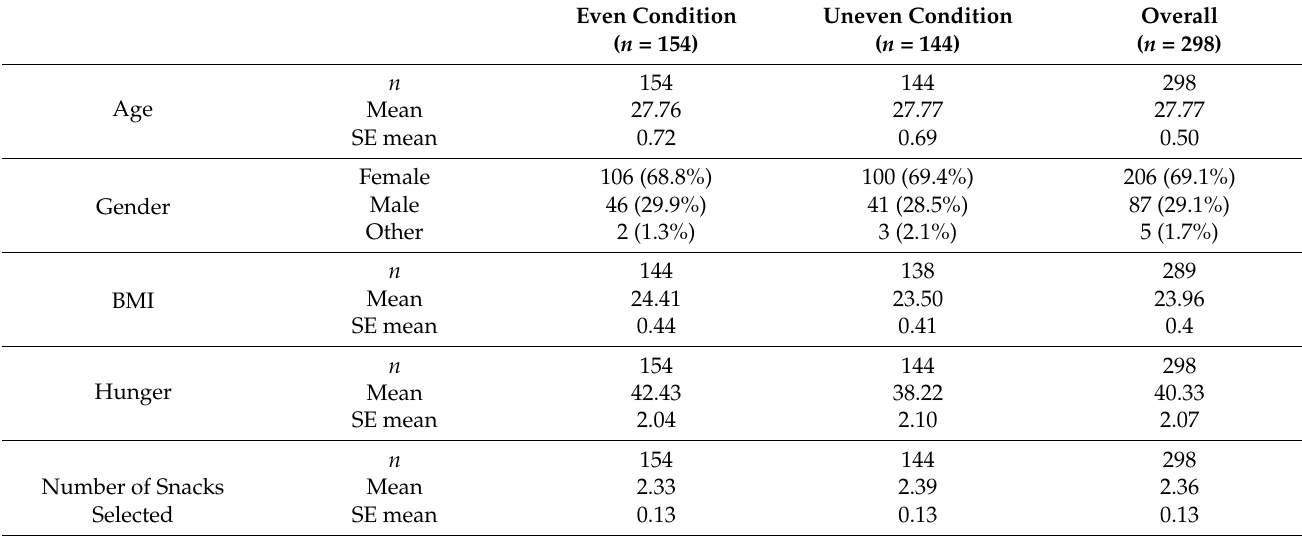
Table 1. Demographic information of the overall sample and the two study conditions. Due to data catchment errors, only complete datasets for each descriptive variable are reported here. The corresponding n is reported for each demographic factor for